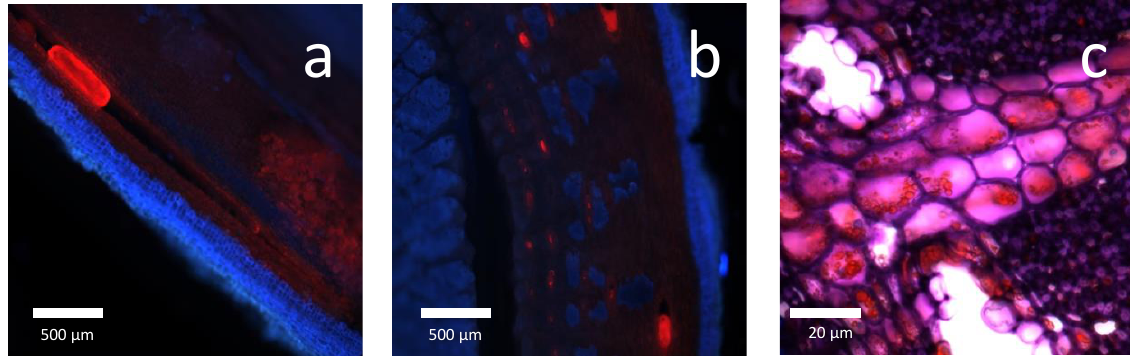
Figure 5. ( a ). Longitudinal section of a guayule branch (resin in red inside a canal, bark in blue)/( b ). Cross section of guayule bark (resin in red, bark in blue)/( c ). Particles of polyisoprene in parenchyma cells (polyisoprene in red) [36].